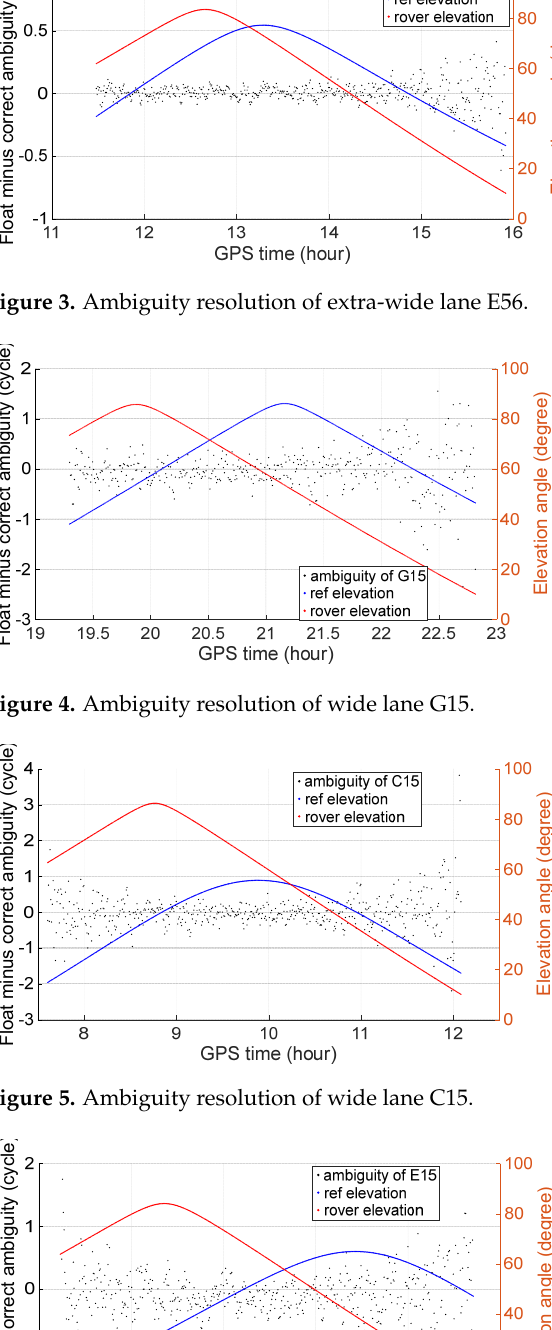
Figure 5. Ambiguity resolution of wide lane C15.